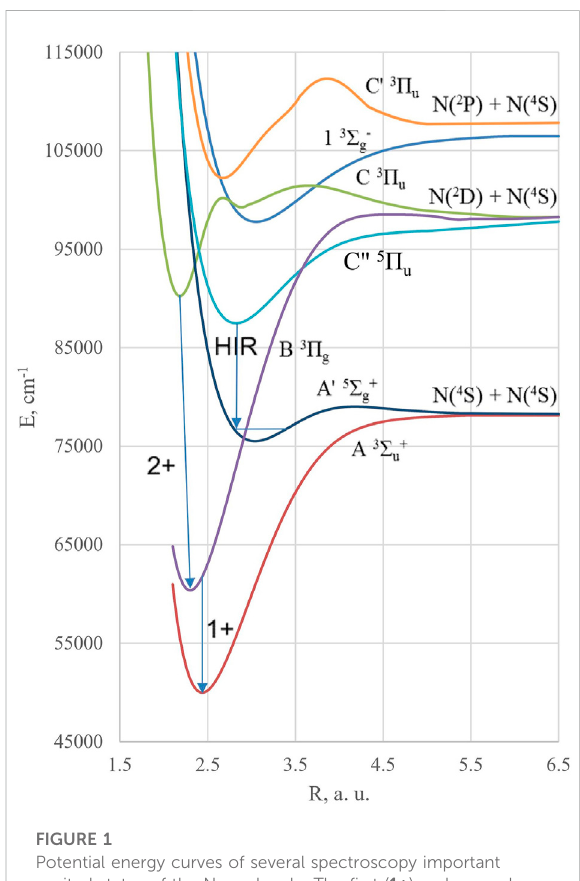
FIGURE 1 Potential energy curves of several spectroscopy important excited states of the N 2 molecule. The fi rst ( 1+ ) and second positive ( 2+ ) systems are denoted together with the Herman infrared (HIR) emission band.